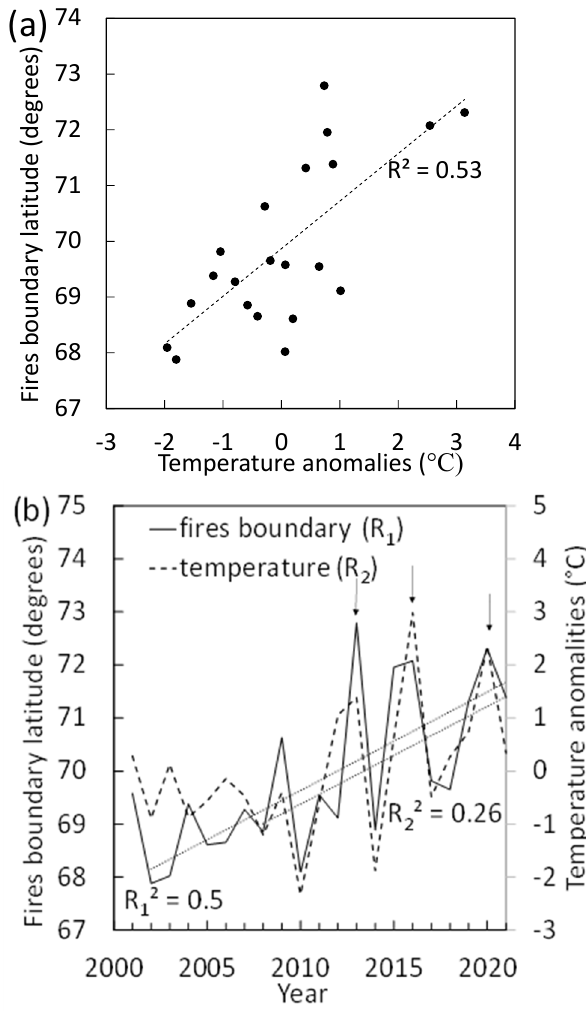
Figure 3. ( a ) Fire boundary norward migration correlated with MJJAS air temperature. ( b ) Fire bound- ary extreme shifts synchronized with air temperature extremes (“heat waves” in 2013, 2015–2016, and 2020 years). Trends significant at p <